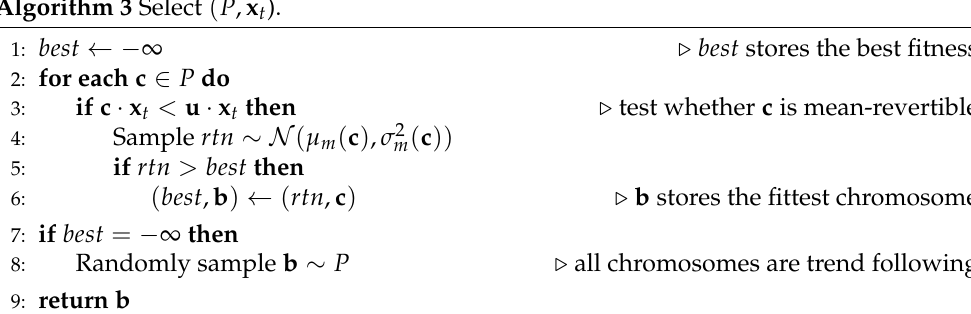
Algorithm 3 Select ( P , x t ).